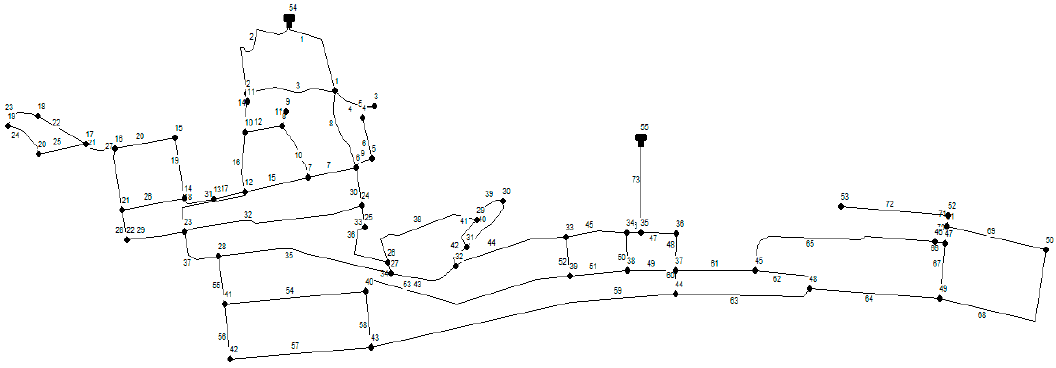
Figure 4. The water network of Praia a Mare (CS, Italy) .